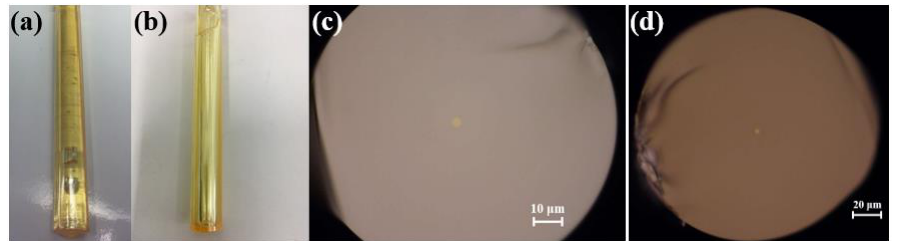
Figure 2. ( a ) Preform of the step−index fluorotellurite fiber; ( b ) Fluorotellurite glass tube; ( c ) Cross−section of TBZL/TWZN fiber; ( d ) Cross−section of TWPN/TZPNG fiber.